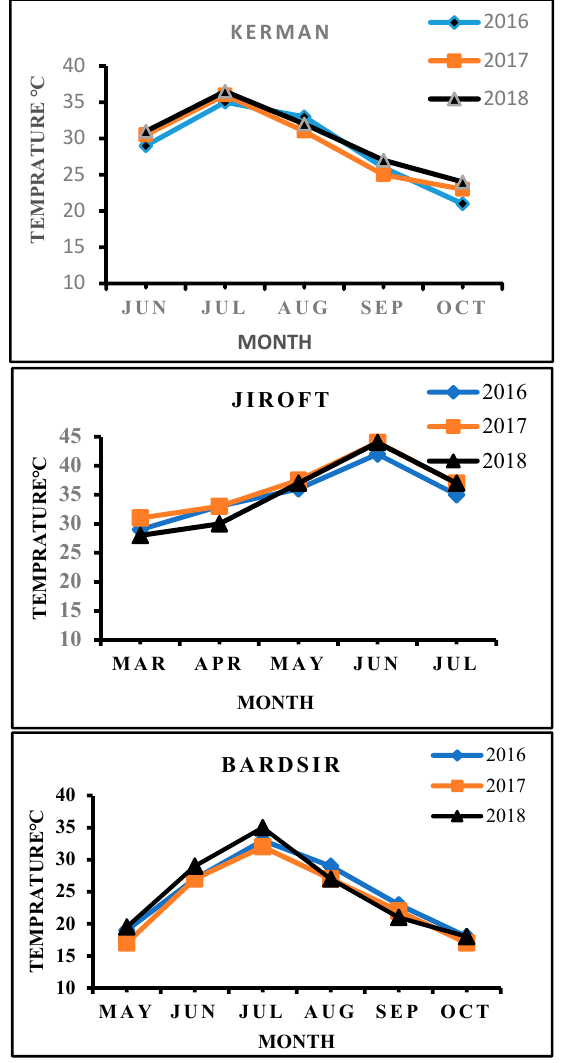
Figure 1. The temperature In Kerman, Jiroft, and Bardsir in three years.